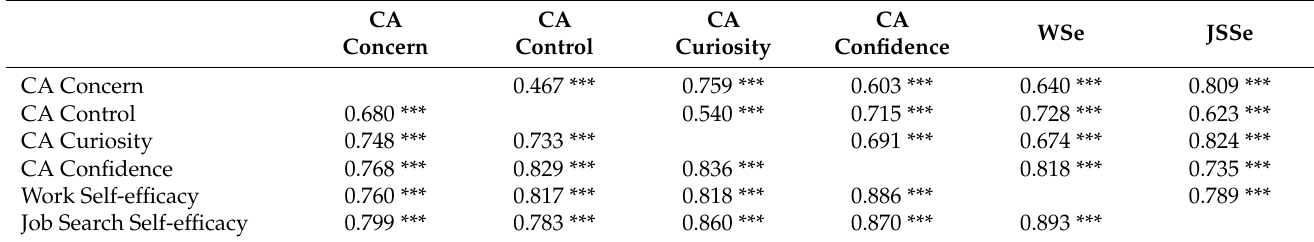
Table 2. Bivariate correlations between variables.